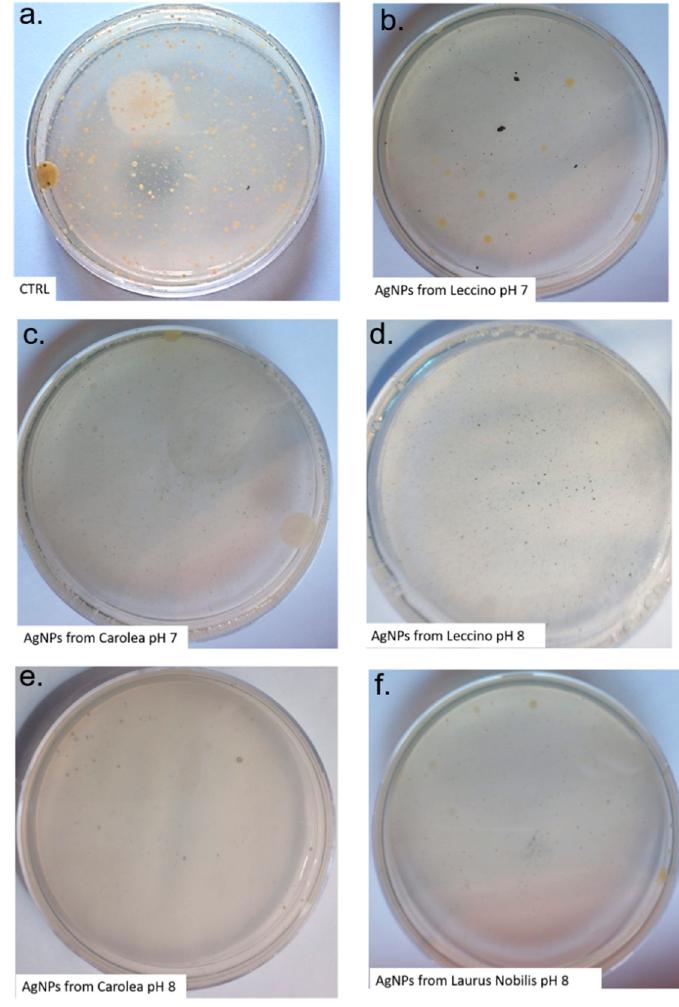
Figure 11. Total bacteria detection by plate count techniques to test colonies at 37 ◦ C. 50 µ g / mL of green AgNPs derived from Leccino , Carolea at pH 7 ( b , c ) and from Leccino , Carolea and Laurus Nobilis and pH 8 ( d , e , f ) were added in water before inoculation to test the antibacterial activity. Table 3. Total colonies at 22 °C and 37 °C as UCF/ml and total coliforms and faecal coliforms as MPN/100ml after exposure to 50 μ g/ml of green AgNPs.